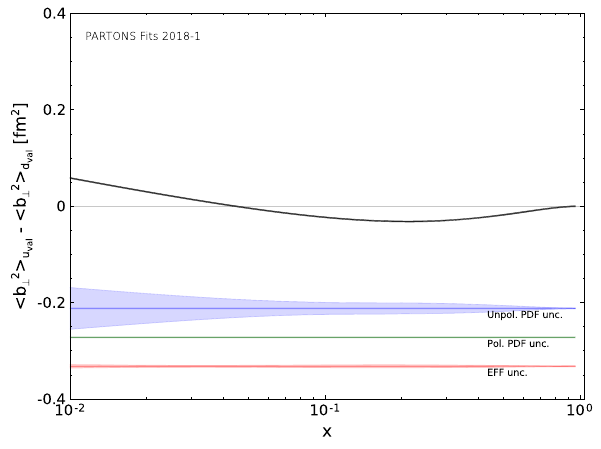
( x ) and (cid:5) b 2 (cid:6) ( x ) , cf. Fig. 16. ⊥ u val d val